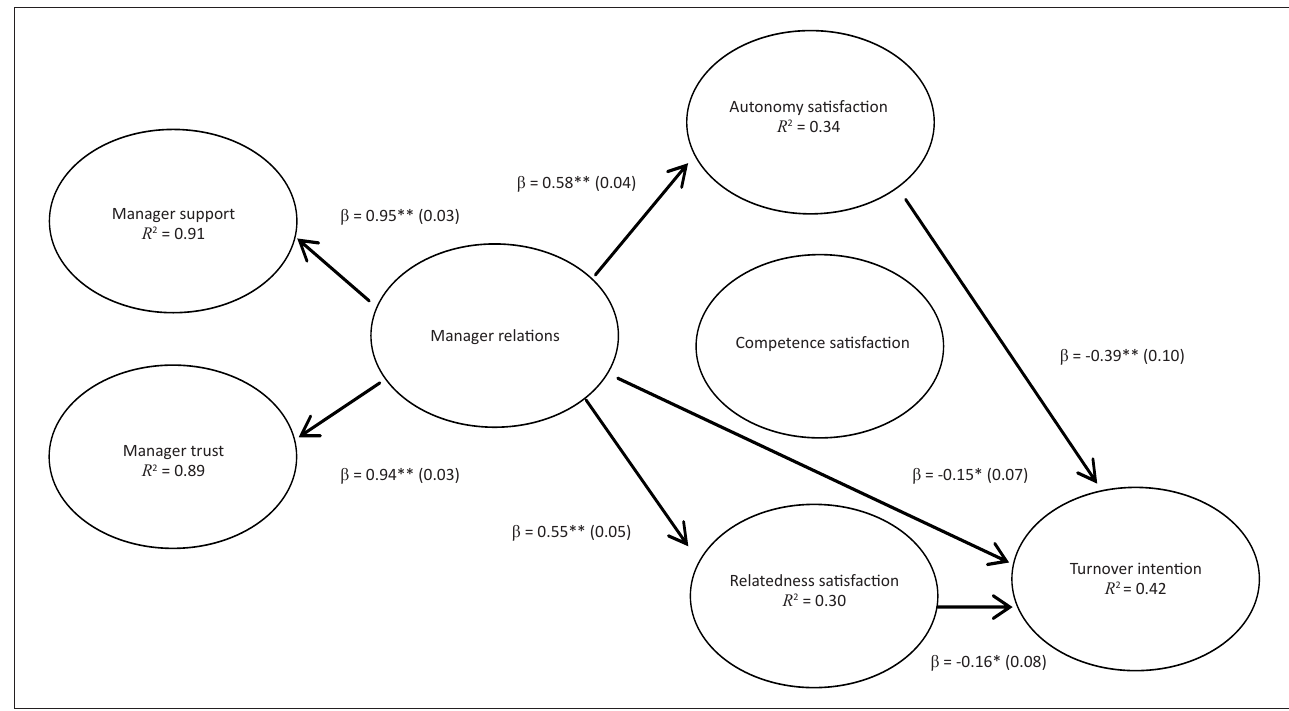
FIGURE 1: The structural model – standardised solution with standard errors in parentheses (*, p < 0.05; **, p <